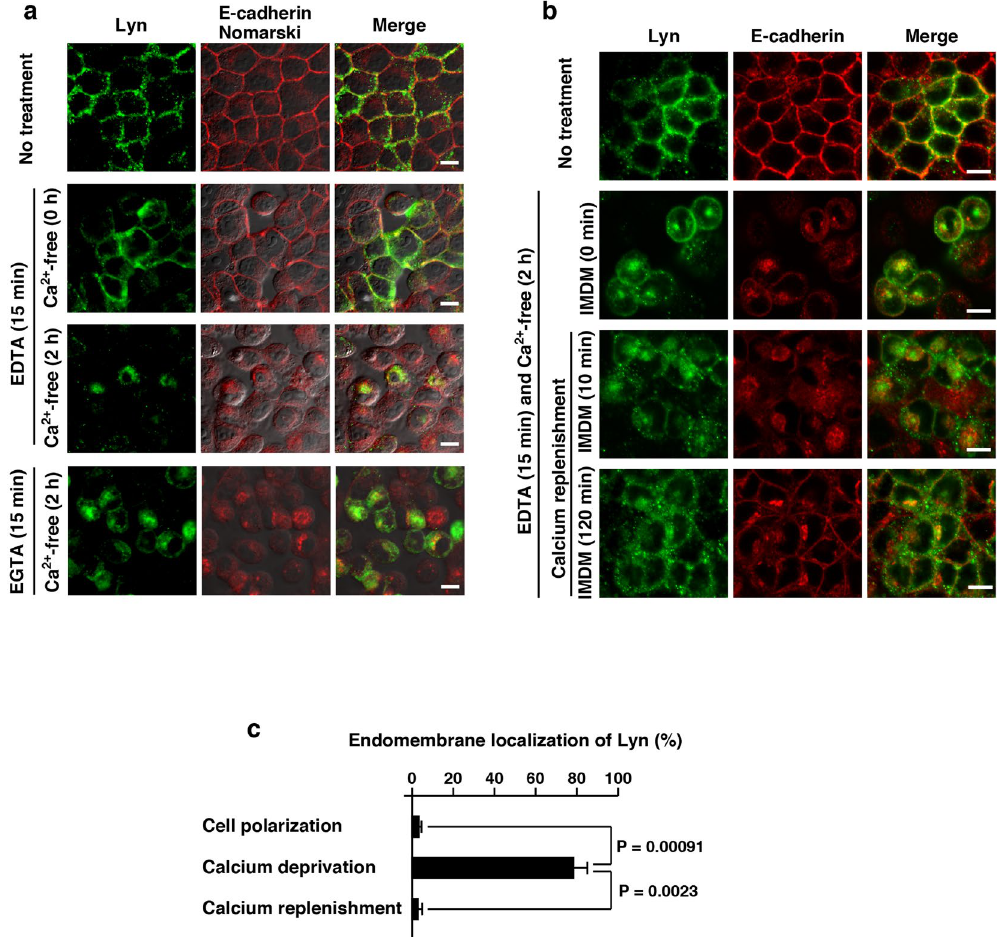
Figure 6. Translocation of Lyn to endomembranes by calcium deprivation. (a) MDCK/TR/Lyn cells cultured to confluence (polarized cells) were treated with 1 μ g/ml Dox for 8 h, then treated with 4 mM EDTA or 4 mM EGTA for 15 min and subsequently cultured in calcium- and serum-free IMDM for 2 h (calcium deprivation). Cells were fixed and stained with rabbit anti-Lyn antibody (green) and anti-E cadherin antibody (red). Scale bars, 10 μ m. ( b) MDCK/TR/Lyn cells cultured to confluence (polarized cells) were treated with 1 μ g/ml Dox for 8 h, then treated with 4 mM EDTA for 15 min and further incubated in calcium- and serum-free IMDM for 2 h (calcium deprivation), and subsequently incubated with IMDM containing 5% bovine serum for 10 min and 120 min (calcium replenishment). Cells were stained with anti-Lyn and anti-E-cadherin antibodies. Scale bars, 10 μ m. ( c) MDCK/TR/Lyn cells cultured to confluence (polarized cells) were treated with 1 μ g/ml Dox for 8 h, then treated with 4 mM EDTA for 15 min and further incubated in calcium- and serum-free IMDM for 2 h (calcium deprivation), and subsequently incubated with IMDM containing 5% bovine serum for 20 h (calcium replenishment). Cells were stained with anti-Lyn antibody (green) and propidium iodide. The number of cells in which Lyn was predominantly accumulated to endomembranes was counted. The data represent the mean ratio ± S.D. from three independent experiments in which at least 50 cells for each category were scored. The significant differences are calculated by one-tailed Student’s t